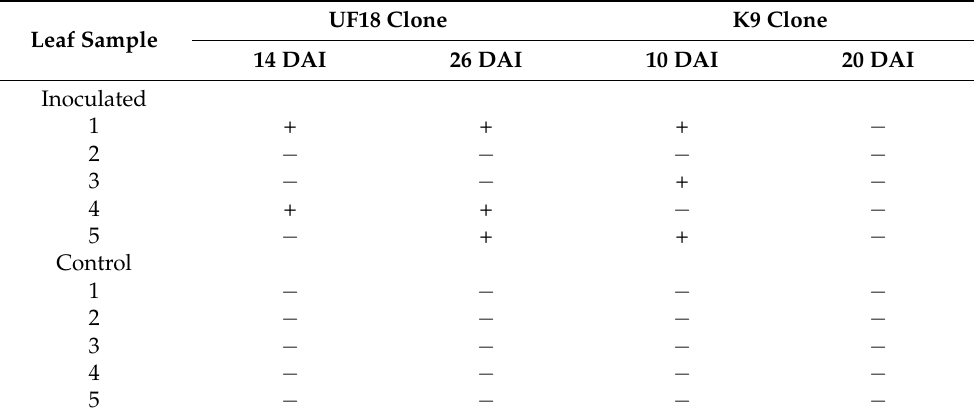
Table 1. Re-isolation of C. siamense from inoculated cacao leaves by spraying method at different sampling times (days after inoculation, DAI).